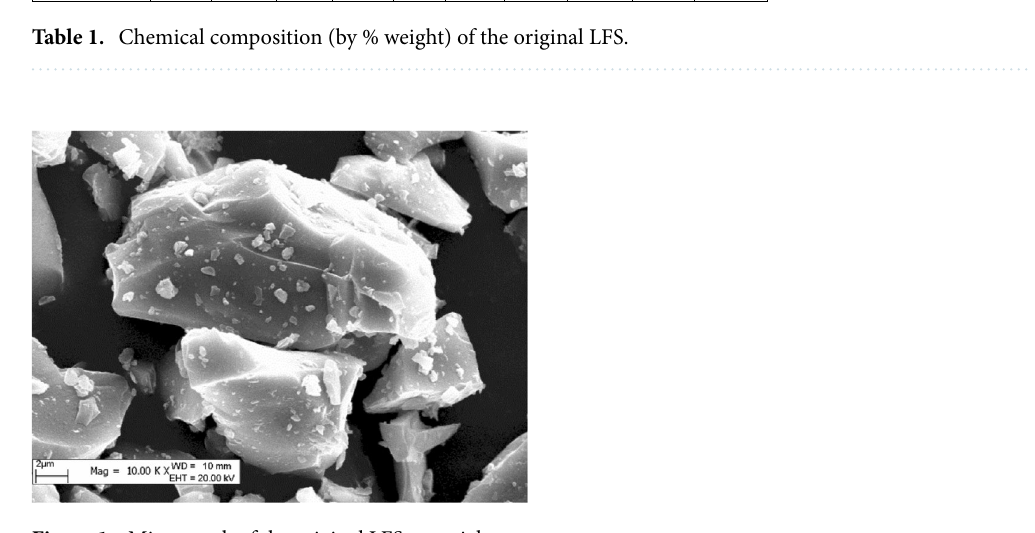
Figure 1. Micrograph of the original LFS